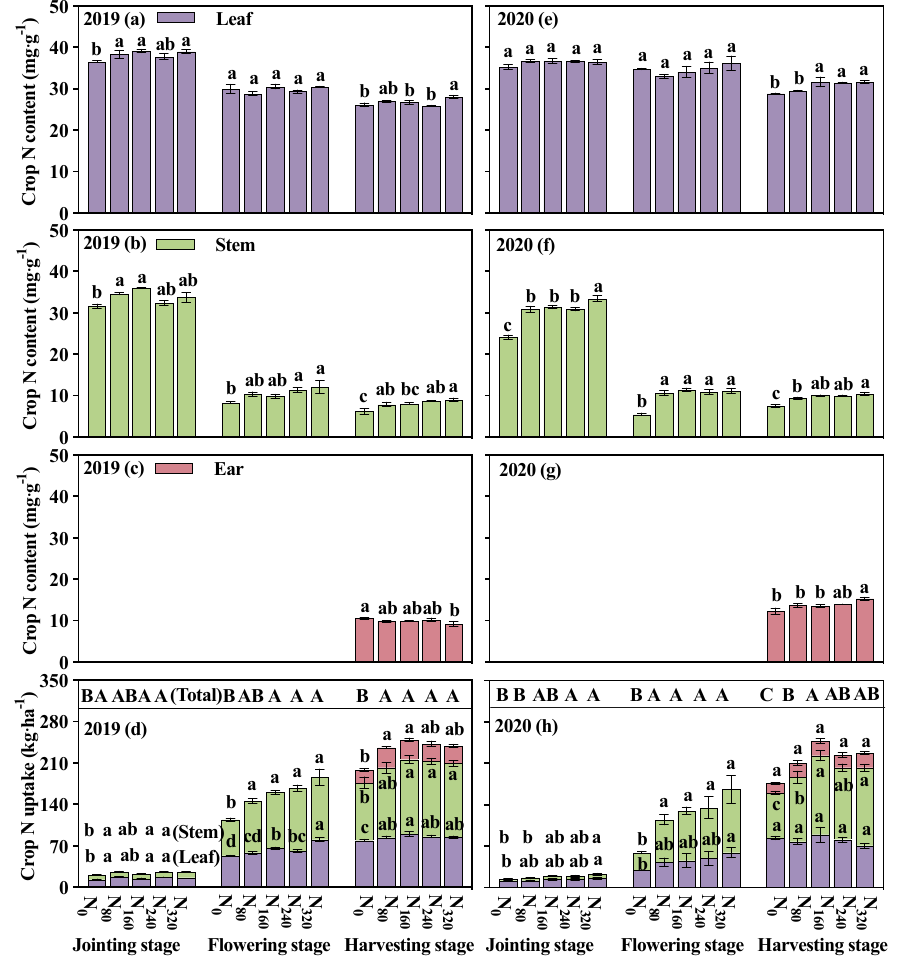
Figure 4. Crop N content to different parts ( a − c , e − g ) and crop N uptake ( d , h ) at the jointing, flowering, and harvesting stages of forage sorghum under different N application rates in 2019 and 2020. Different lowercase letters in the same growth stages for the same part (leaf, stem, and ear) represent significant differences at p < 0.05 among the different N treatments. Different capital letters in the same growth stages indicate significant differences at p < 0.05 in total crop N uptake of forage sorghum among the different N treatments.